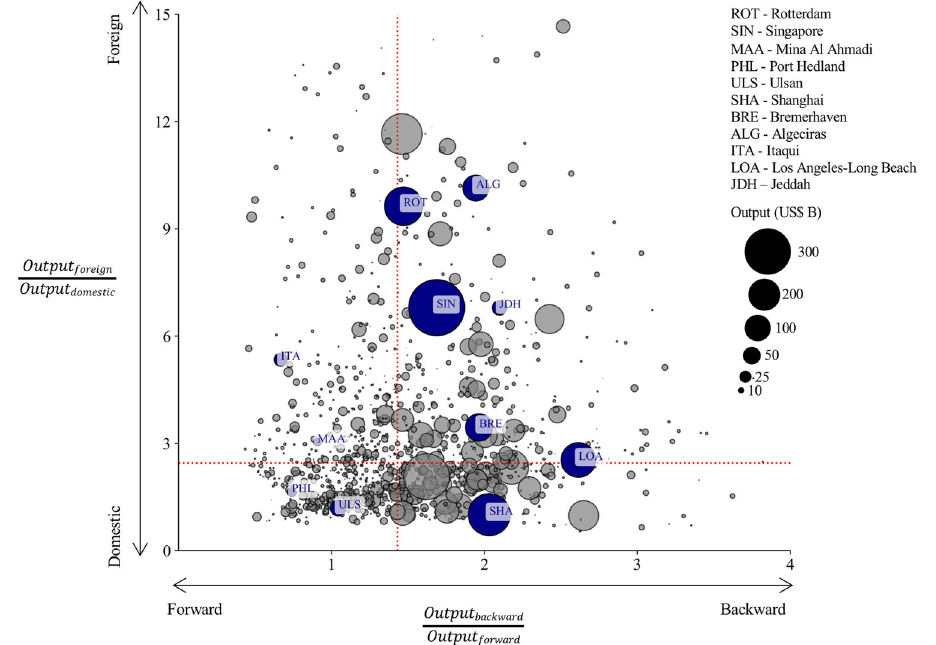
Fig. 5 | The relative importance of forward/backward and domestic/foreign port-industry linkages. The contribution of port-level trade to total output sub- divided into forward and backward economic linkages and domestic and foreign economiclinkages,capturingtherelativeimportanceofthefourcomponents.The